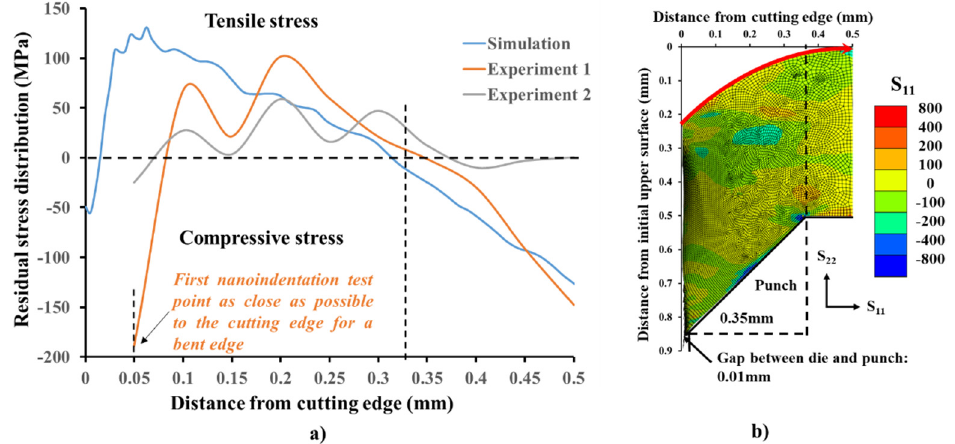
Figure 9. ( a ) Residual stress distribution on the surface after punching. Blue and red lines show, respectively, the simulated residual stress in S 11 direction and the residual stress tested by nanoindentation. ( b ) Residual stress distribution in the longitudinal section of the cutting edge. The red arrow indicates the extraction path of the simulation results in ( a ). arrow indicates the extraction path of the simulation results in ( a